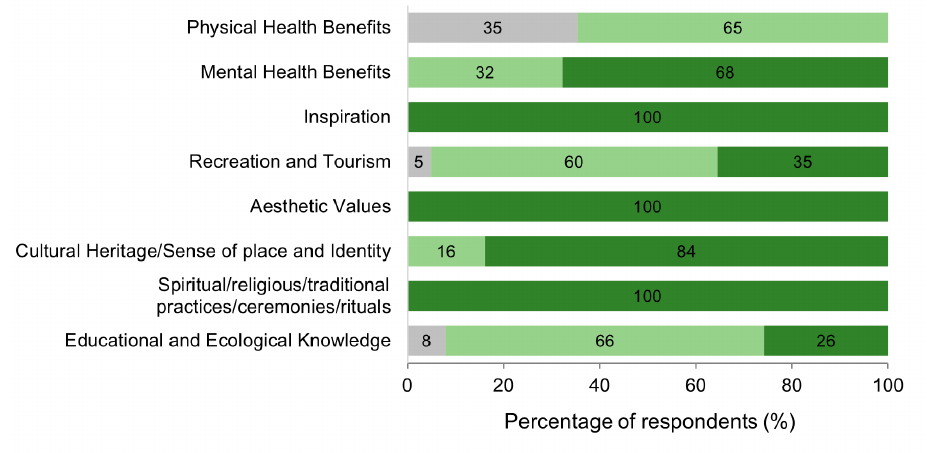
Figure 3. Importance of different cultural ecosystem services in both study sites in the Beas River.